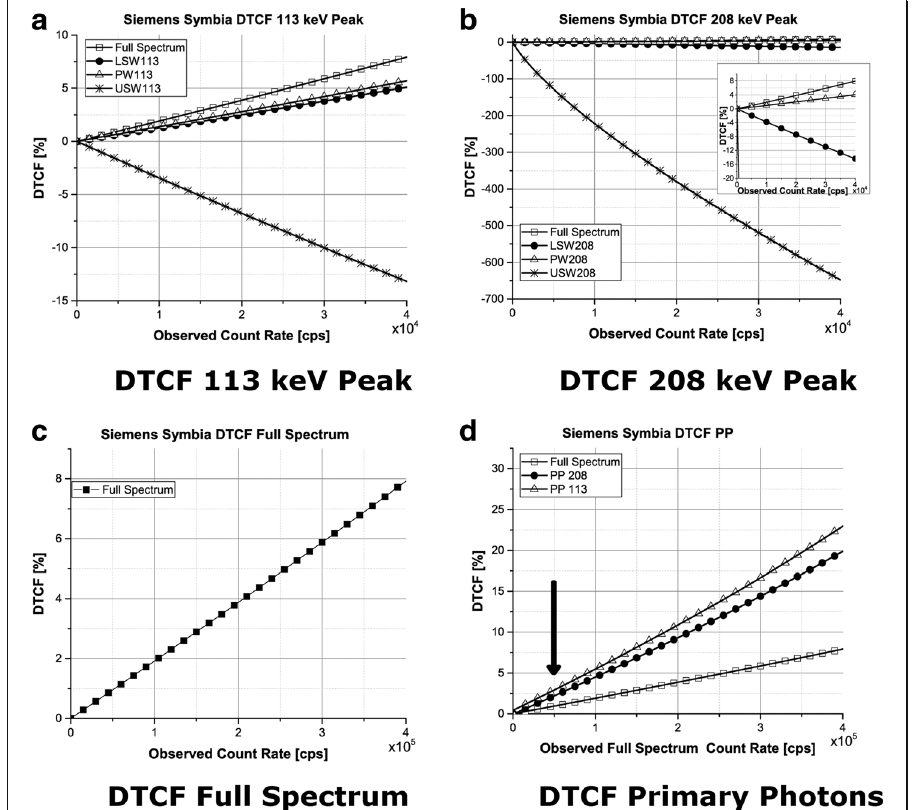
Fig. 7 Deadtime correction factors as a function of the observed count rate. For figures a , b , and c , the observed count rates are those which were recorded in the energy window corresponding to the presented curve (see legend). d DTCF corresponding to PP. Typical values of full spectrum count rates in patient studies (indicated by an arrow) range from 50 to 70 kcps (~ 0.6 × 10 5 cps on this